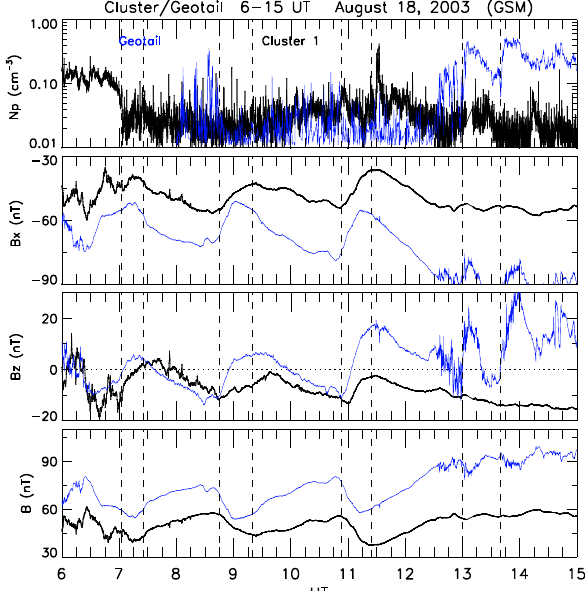
Figure 5. Geotail (blue traces) and Cluster-1 data during the inter- val 06:00–15:00UT. Panels from top to bottom show plasma den- sity and magnetic field components B x , B y , and B z in GSM co- ordinates, and the field magnitude. Intervals of field dipolarization at 07:02–07:25, 08:45–09:20, and 10:53–11:25UT are marked by dashed vertical guidelines. Dipolarization fronts detected by Geotail (not Cluster) at 13:00 and 13:40UT (blue traces) are also marked. vertical guidelines. A different category of events is seen